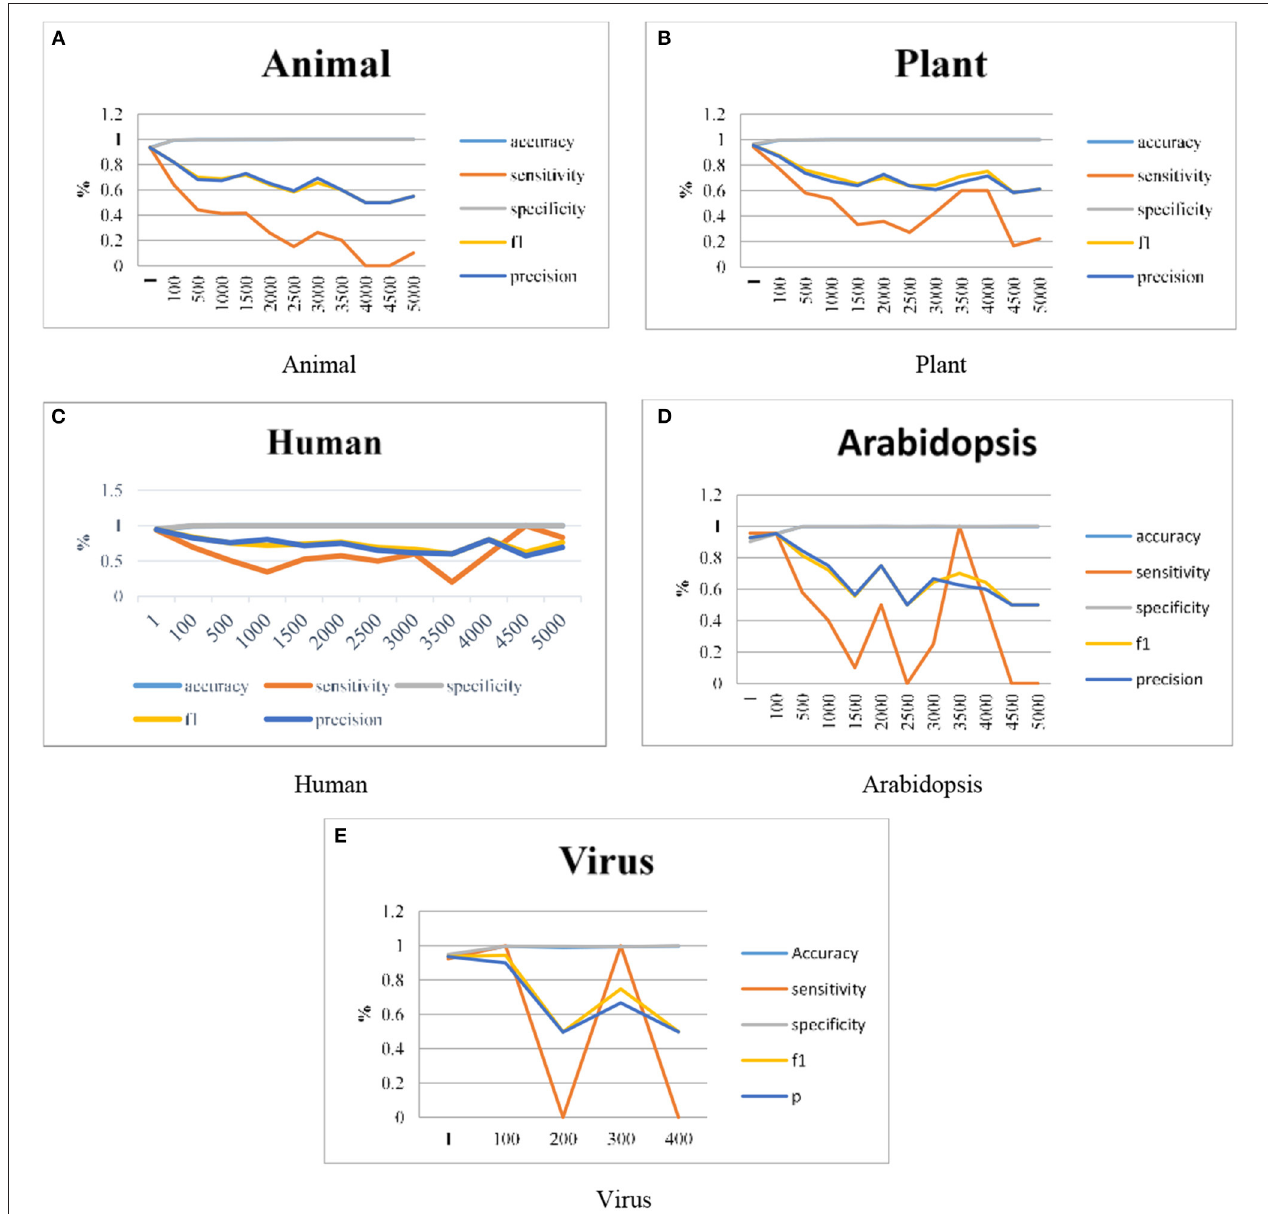
FIGURE 4 | Experimental results using (A) Animal, (B) Plant, (C) Human, (D) Arabidopsis and, (E) Virus genome